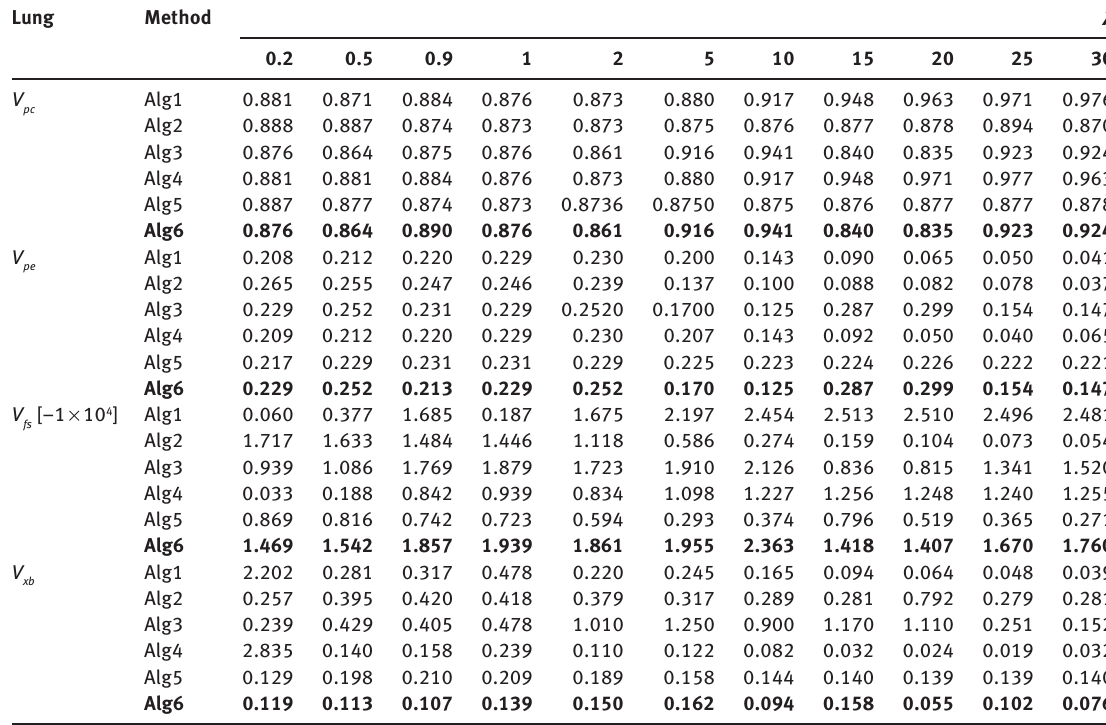
Table 5: Performance Comparison for Lung Images. Lung